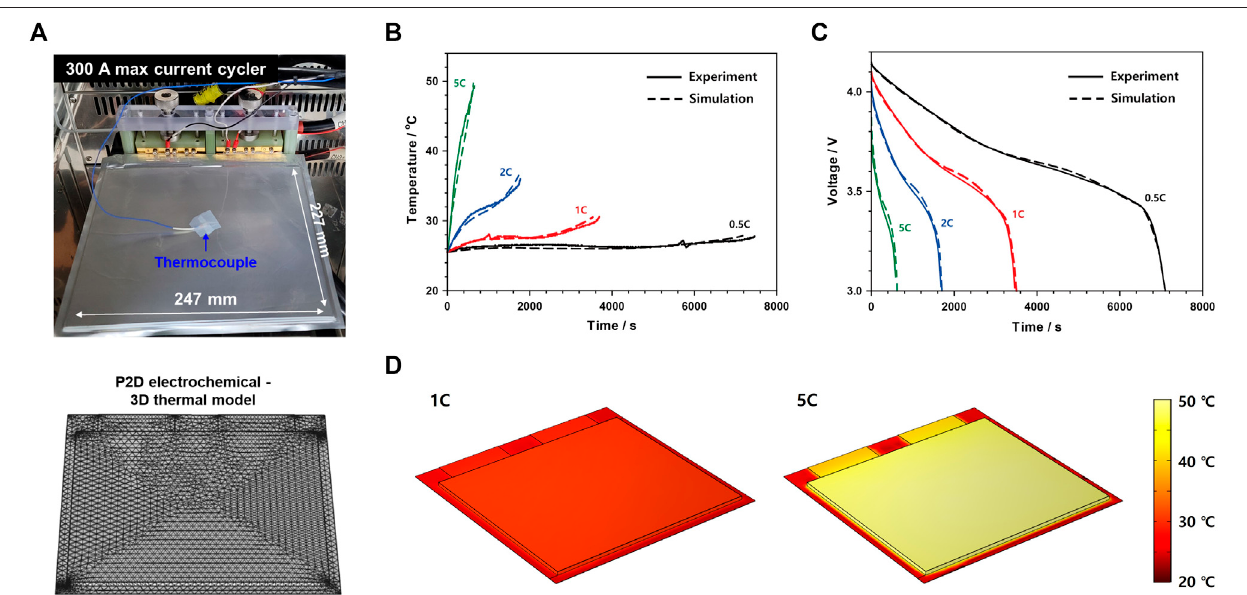
FIGURE 1 | (A) Real image (top) and 3D model structure (bottom) of a 50 Ah-level NMC442/graphite LIB pouch cell. (B) Temperature pro fi les and (C) discharge voltagepro fi lesofthepouchcellatvariousdischargeC-rates(0.5,1,2,and5C)alongwithsimulatedones. (D) Simulatedsurfacetemperaturesofthepouchcellinafully discharged state at different discharge C-rates (1 and 5C).